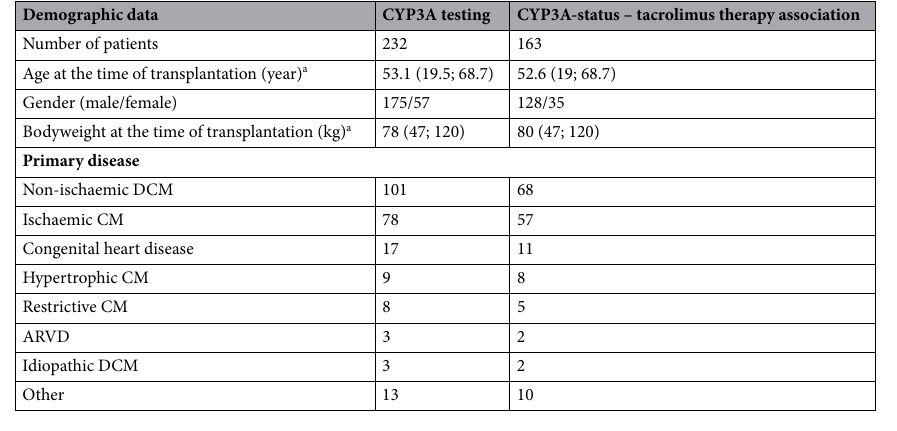
Table 1. Demographic data of the heart transplant patients. ARVD, arrhythmogenic right ventricular dysplasia; CM, cardiomyopathy; DCM, dilated CM. a Median (min;